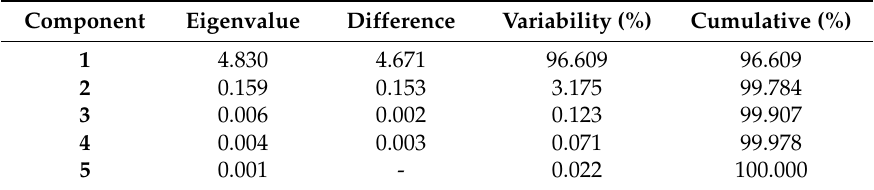
Table 3. The eigenvalues of the five components ( i -propanol concentration).